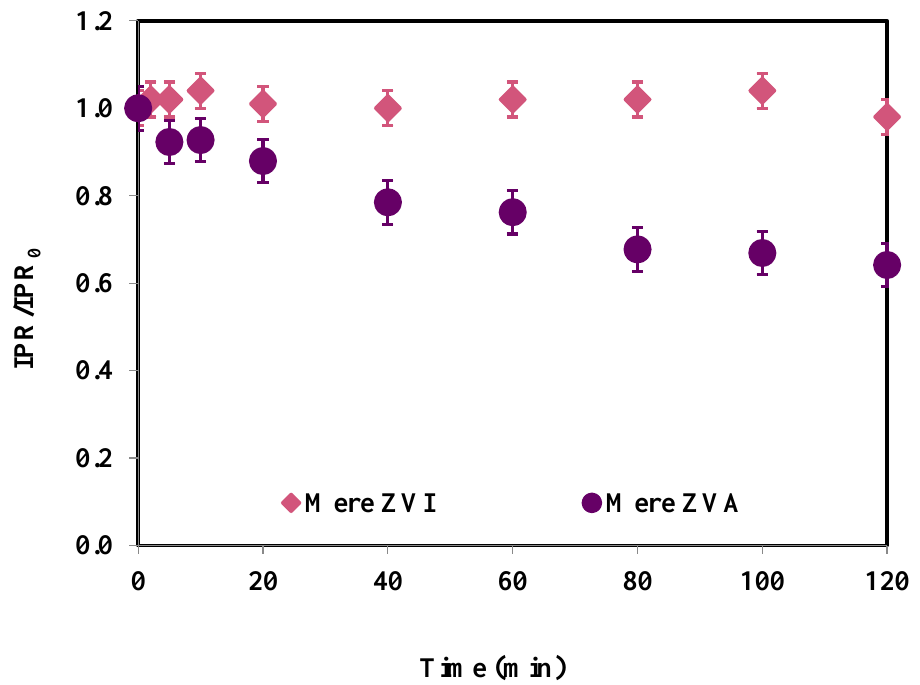
Figure 2. Changes in normalized IPR concentrations during mere ZVI treatment at an initial pH of 5.0 and mere ZVA treatment at an initial pH of 3.0. IPR = 2 mg/L; ZVI = 1 g/L; ZVA = 1 g/L.